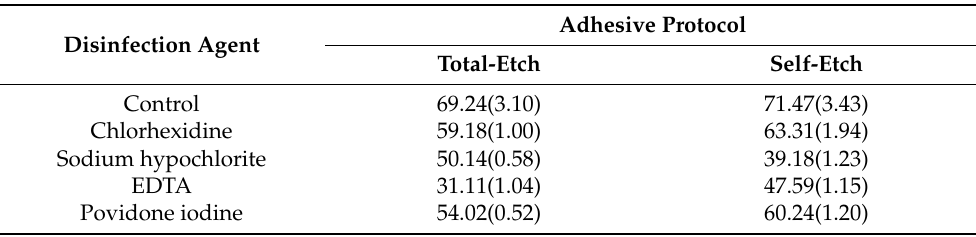
Table 2. Mean microhardness (MV) of dentin surface amongst different surface disinfectants in total-etch and self-etch bonding